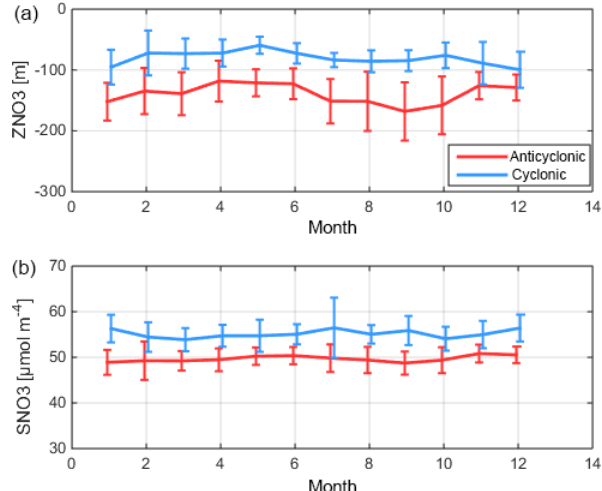
Figure 6. Nitrate + nitrite concentrations versus potential density anomaly data from XIXIMI-2 and XIXIMI-3 survey cruises. Mea- surements corresponding to the intermediate layer are plotted in black and were used for the determination of the linear fit (see text).